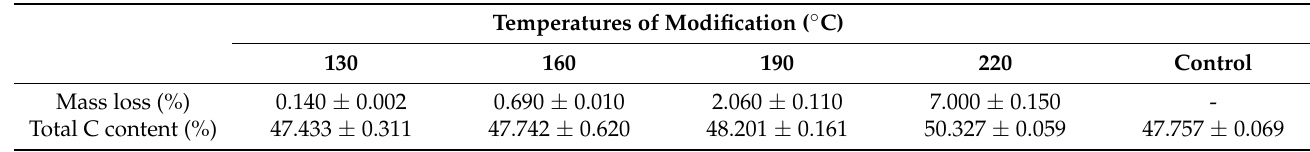
Figure 7. The ATR-FTIR spectra of control wood ( – ), wood modified at 130 °C ( – ), 160 °C ( – ), 190 °C ( – ) and 220 °C ( – ).